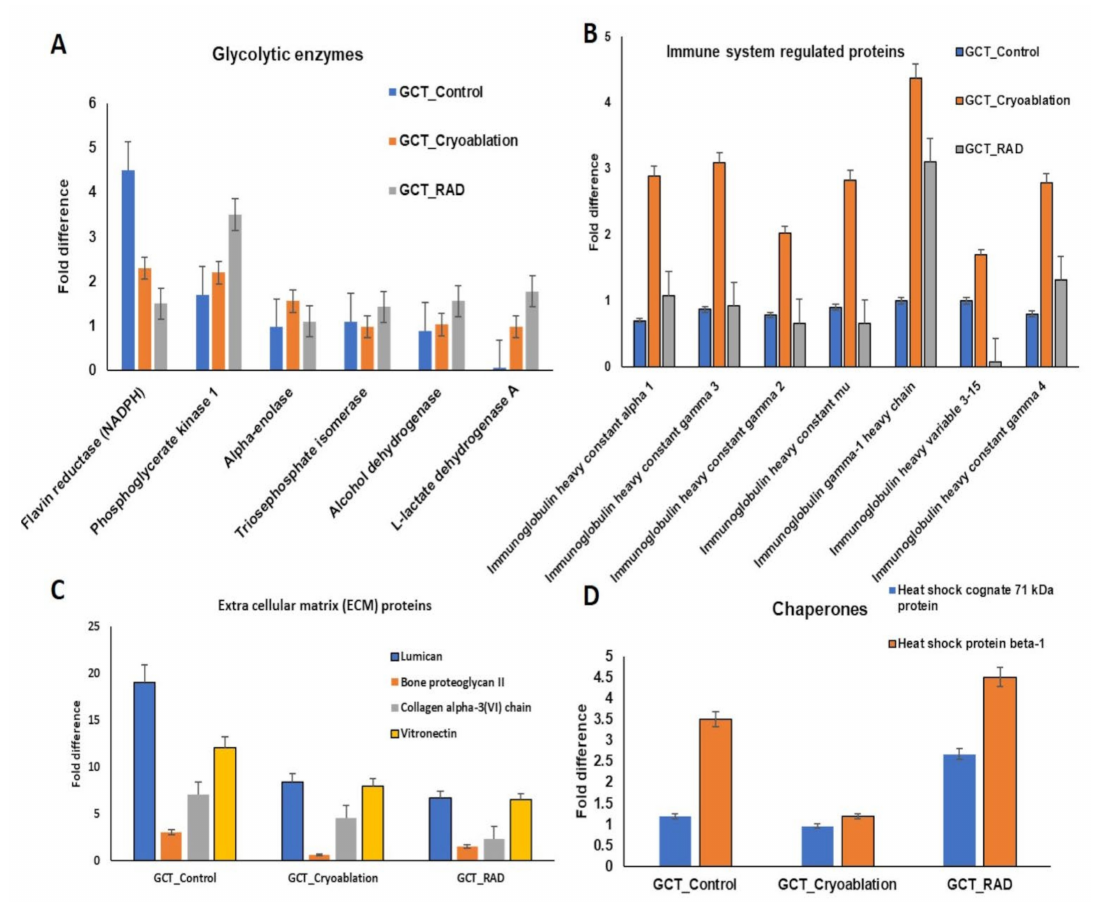
Figure 4. ( A ) Glycolytic enzymes, ( B ) Immune system proteins ( C ) Extra Cellular Matrix (ECM) proteins ( D ) Molecular Chaperons proteins that were significantly down-regulated from GCT-untreated / control compared to GCT-cryoablation and GCT-irradiation / GCT-RAD treated were identified using liquid chromatography tandem mass spectrometry were quantified using label-free quantification, after cryoablation and irradiation treatment the proteins were positively regulated p < 0.01 and FDR > 0.01. p values represented in the figure corresponds to the two-tailed Student’s t -test. Error bars denote mean ±